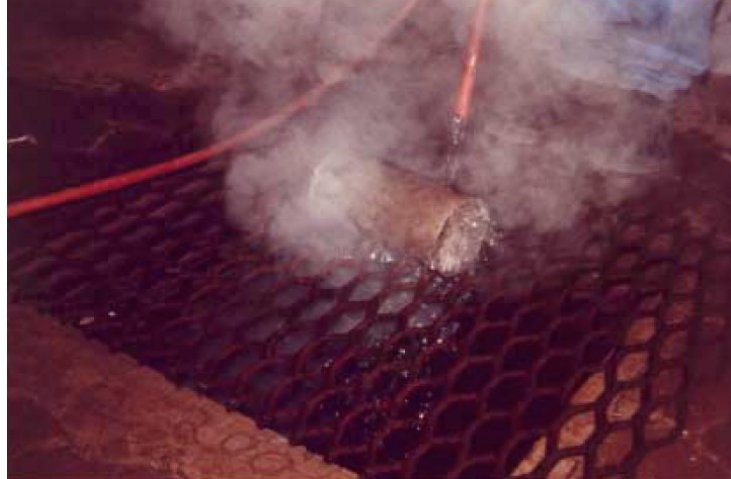
Figure 2. Subtle cooling of test specimens by water aspersion.